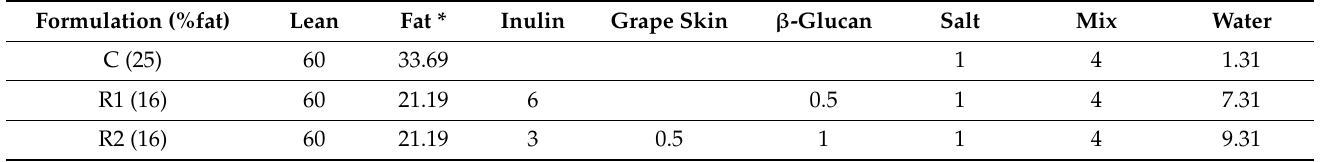
Table 1. Formulations used in preparing the fuet sausages